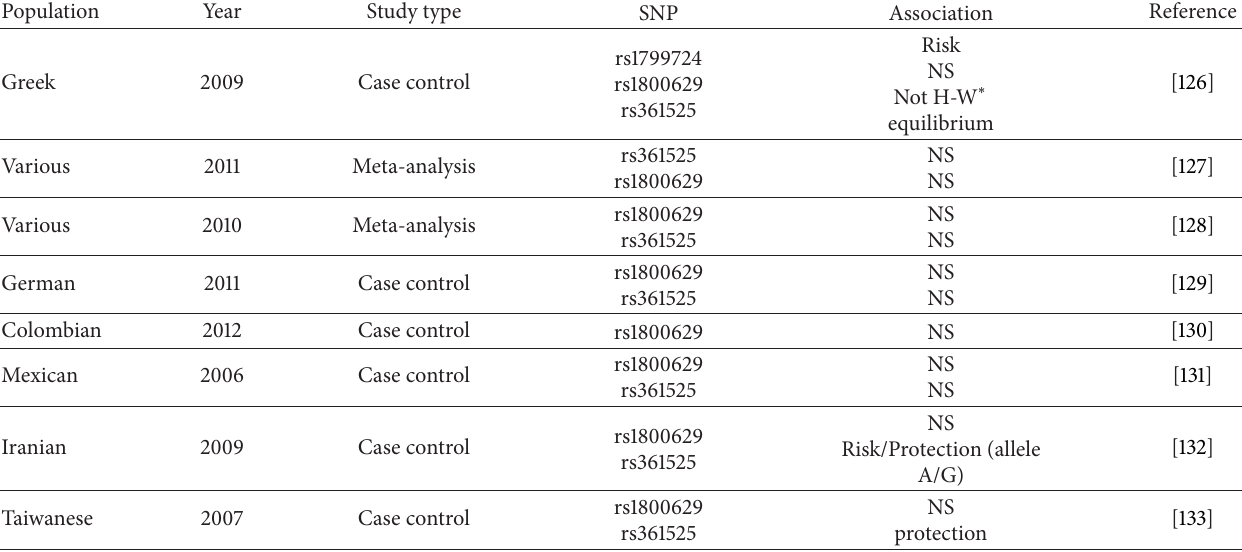
Table 4: Association studies of TNFA polymorphisms with ankylosing